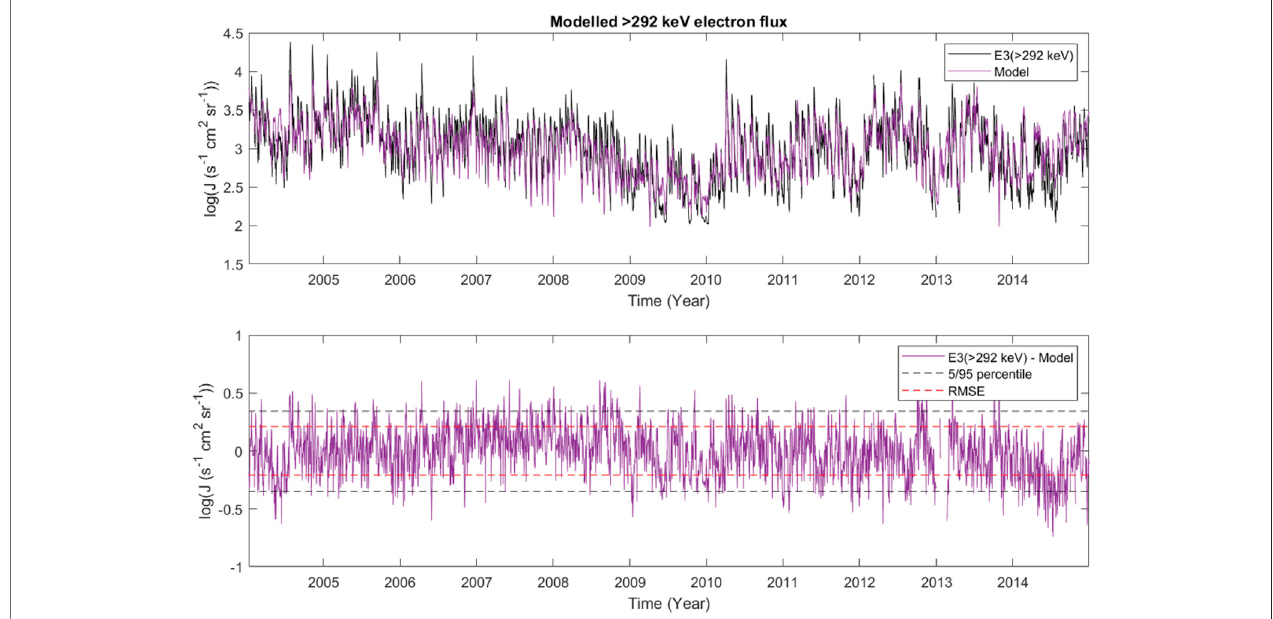
FIGURE 10 | The upper panel shows the observed (black) and modelled (purple) daily resolved fl uxes > 292 keV in the period from 2004 to 2014. The lower panel shows the difference between the observed and modelled fl uxes.